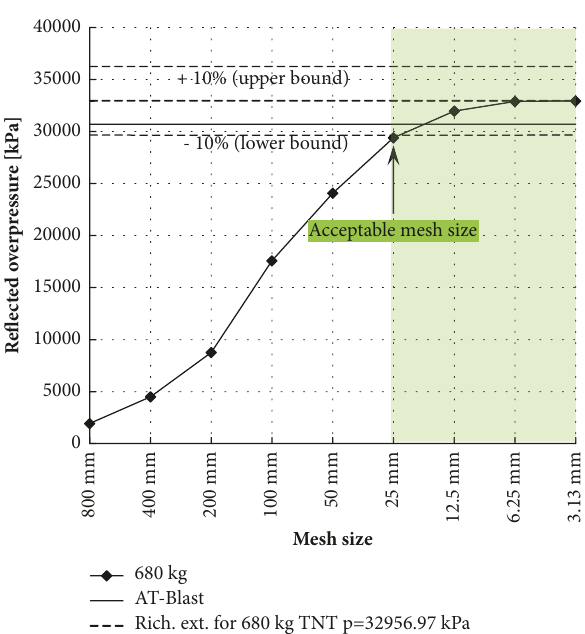
Figure 9: Determination of acceptable air mesh size for reflected